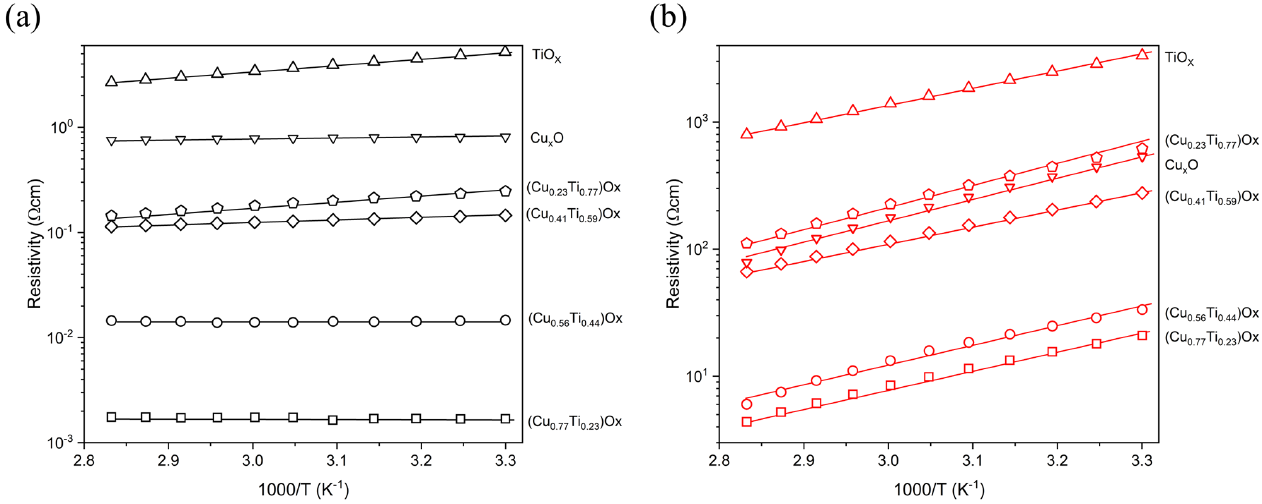
Figure 7. Temperature dependent resistivity of ( a ) as-deposited and ( b ) annealed at 473 K thin